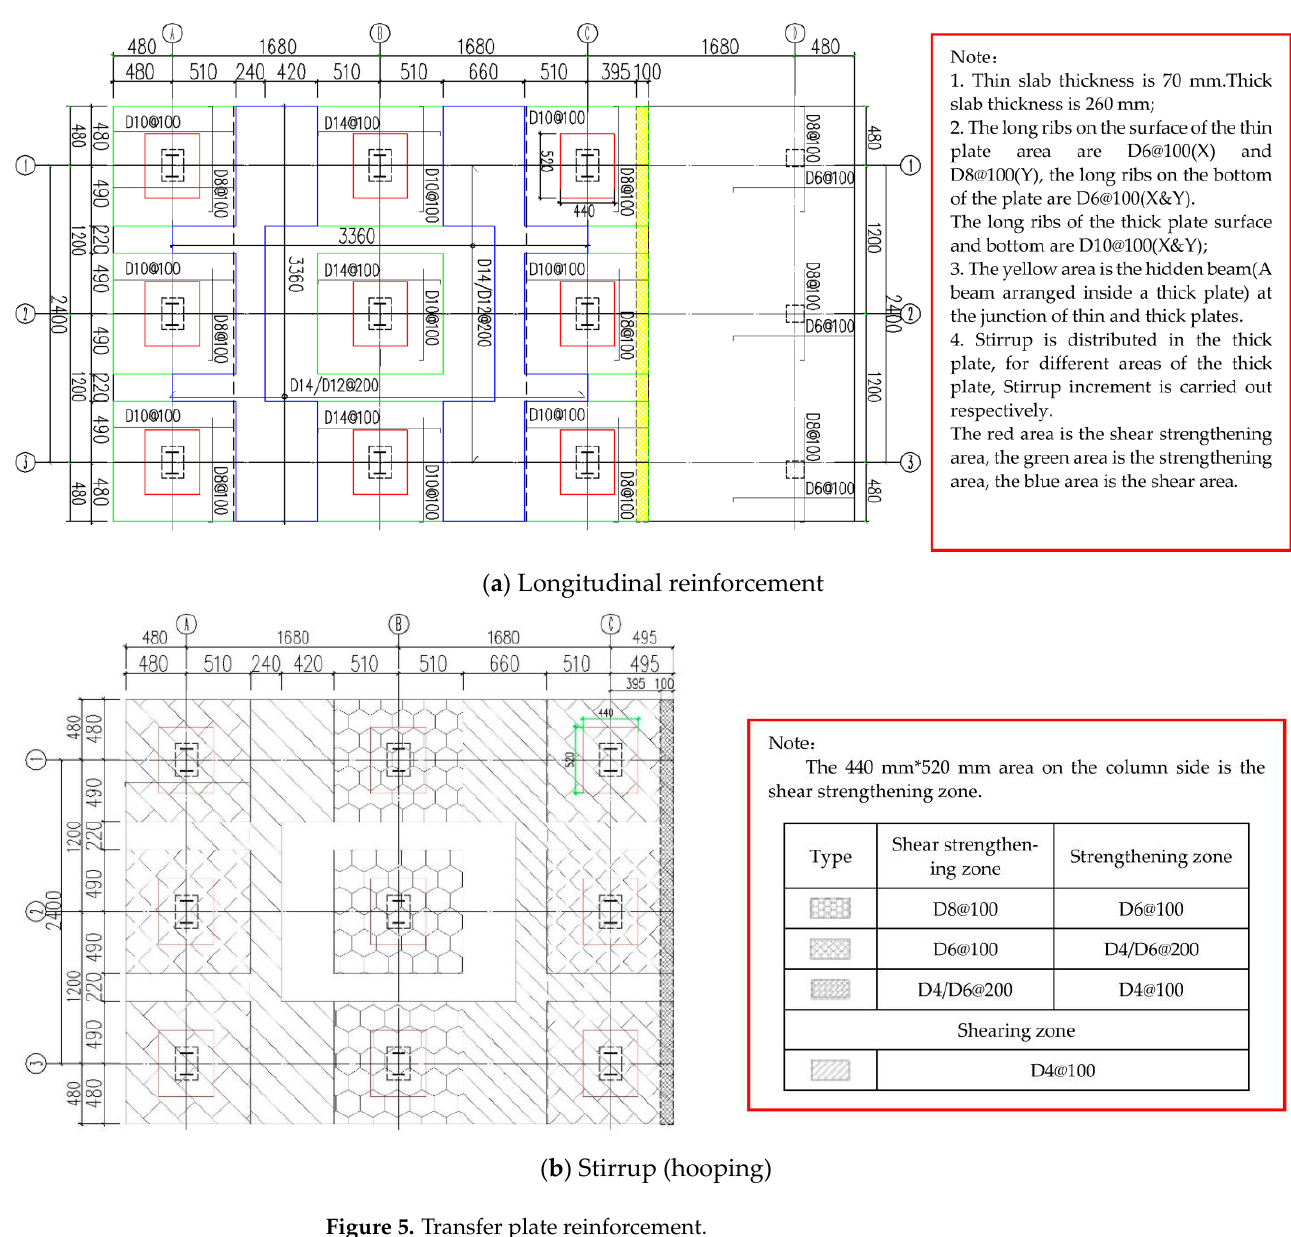
Figure 4. Column reinforcement diagram.